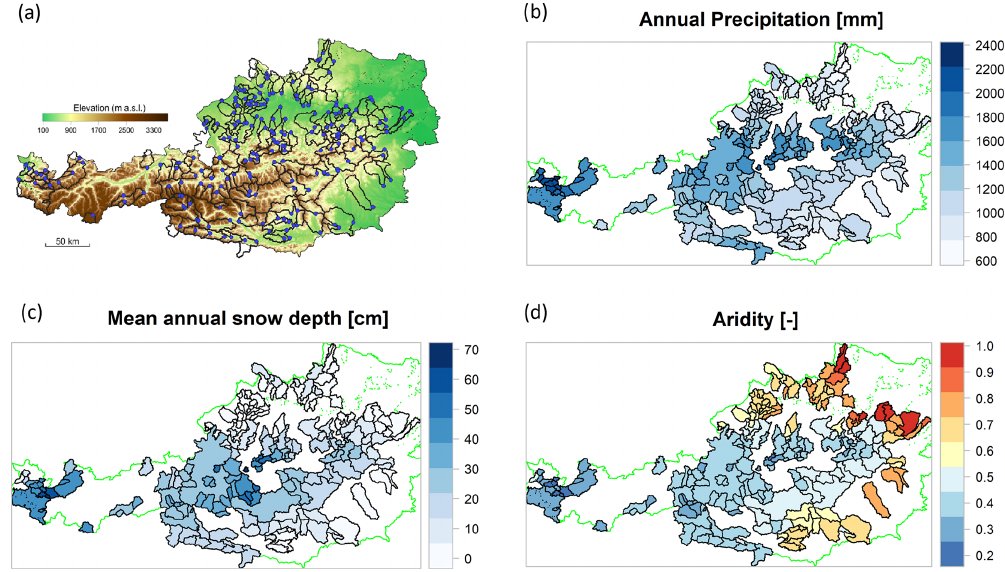
Figure 1. (a) Study area: blue points refer to stream gauges and black lines to catchment boundaries. (b, c, d) Spatial patterns of some climatic catchment attributes across the study area. Table 1. Available catchment